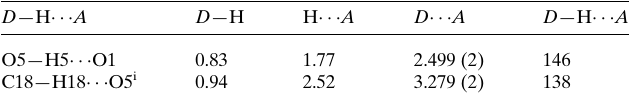
Table 1 Hydrogen-bond geometry (A˚ , (cid:2) ).